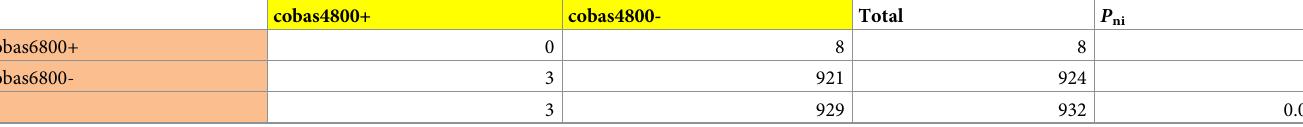
Table 3. Comparison of cobas 4800 and cobas 6800 specificity in the 933 pairs of valid samples from control women without